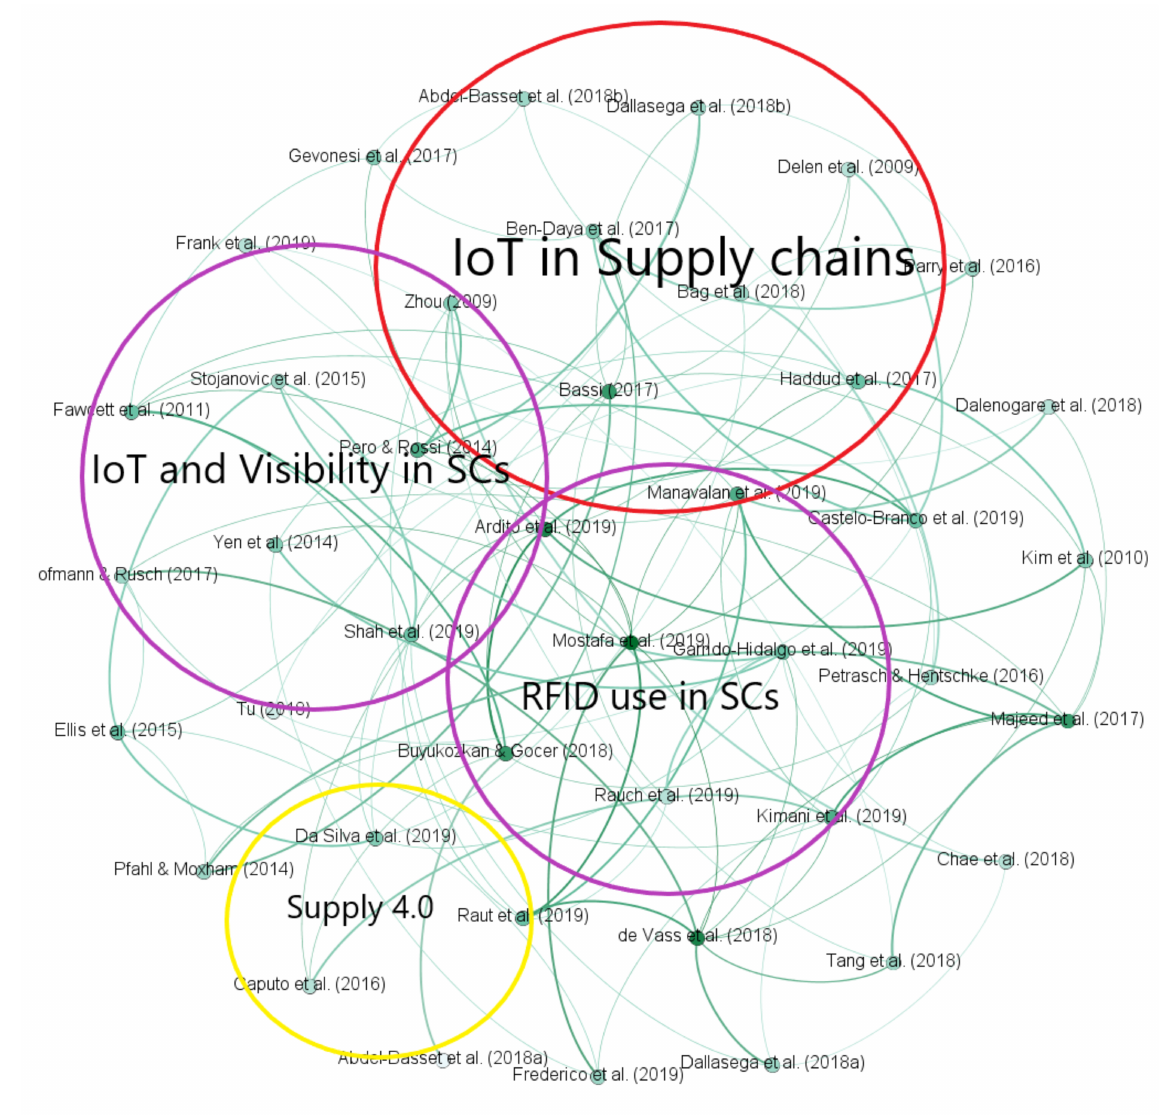
Figure 10. Co-citation analysis using